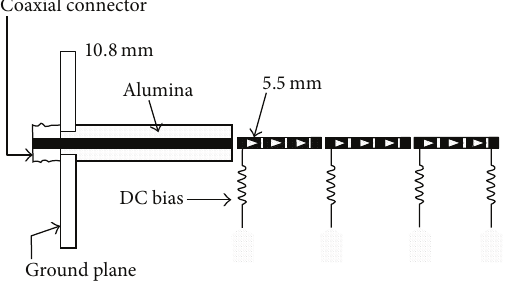
Figure 18: Assembled monopole unit